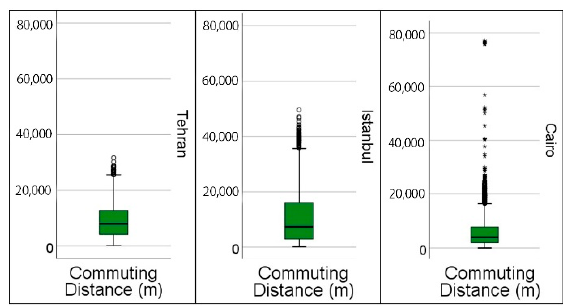
Figure 4. Comparative illustration of commute distances in Tehran, Istanbul, and Cairo.